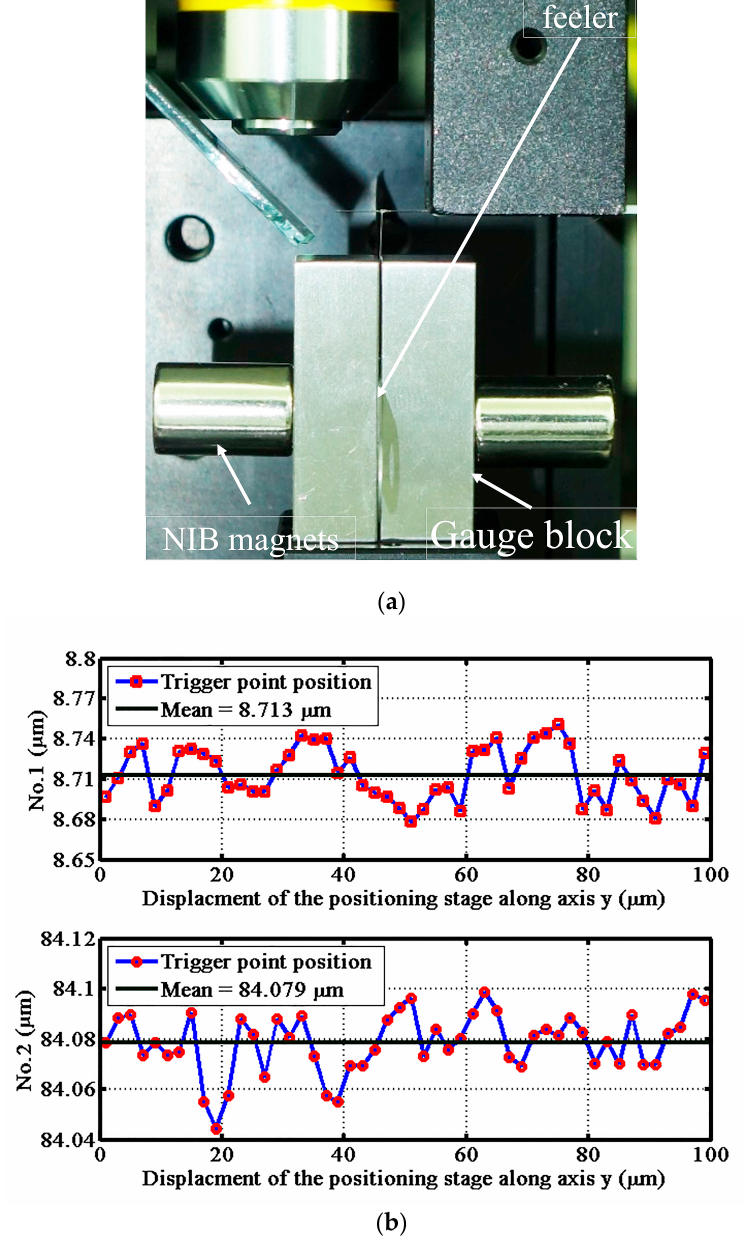
Figure 12. Measurement of the silt: ( a ) photograph of the micro slit and ( b ) the measurement results of the two trigger points.